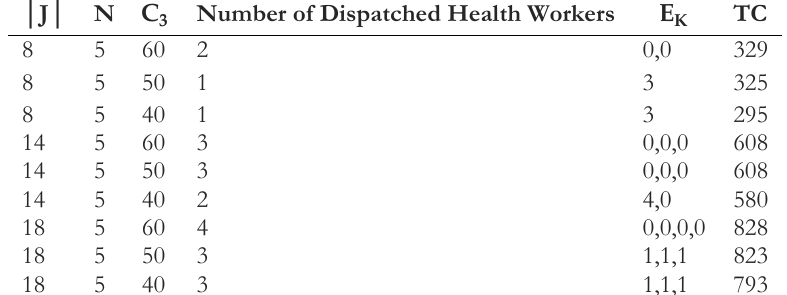
Table 7. Sensitivity analysis on the cost of assigning additional patients to each health worker.